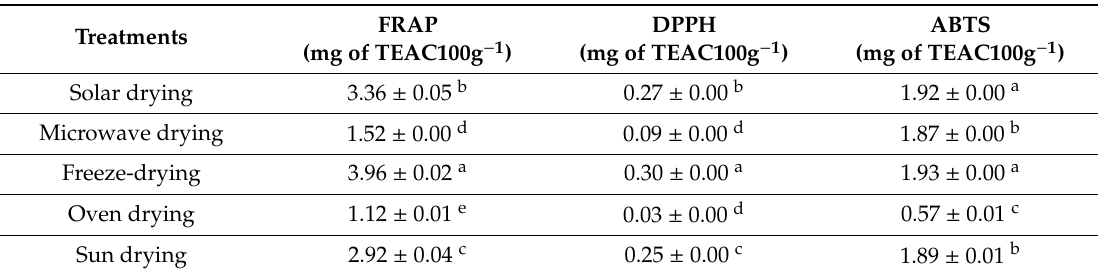
Table 12. E ff ect of di ff erent postharvest drying methods on antioxidant activities in Nightshade leaves.